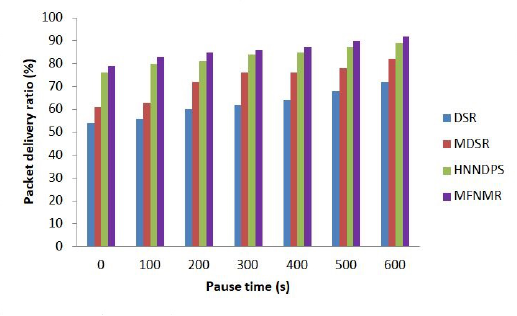
Figure 15. PDR Analysis based on Pause